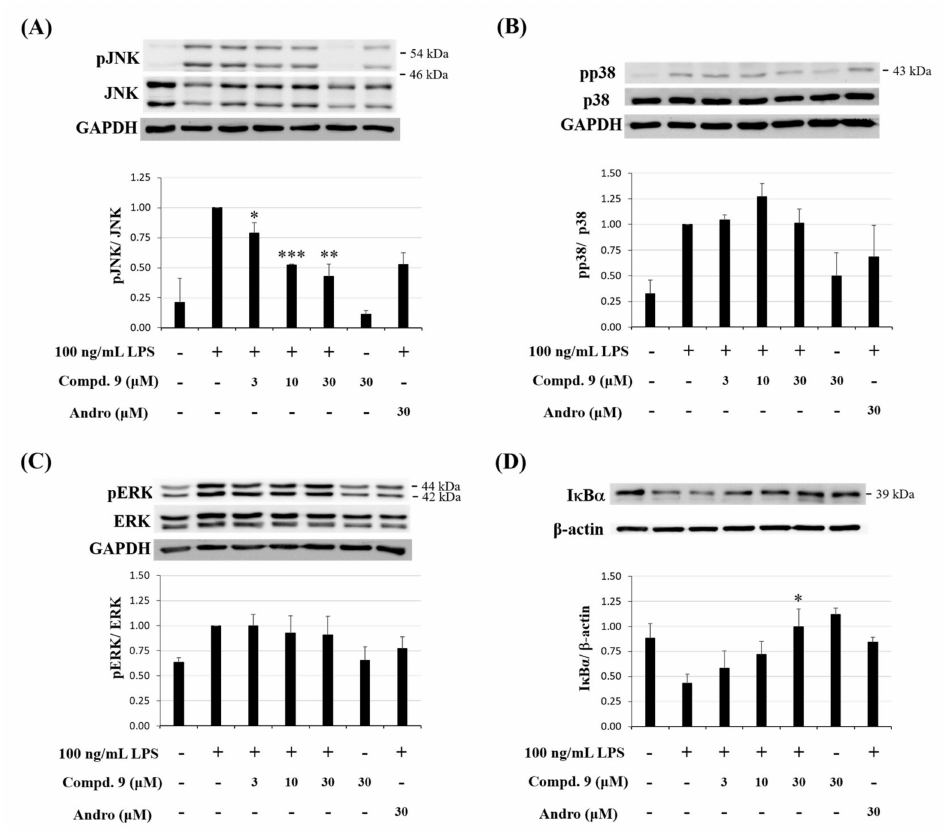
Figure 11. E ff ect of otogirinin A ( 9 ) on the phosphorylation of MAPKs and NF- κ B pathways in LPS-stimulated RAW264.7 macrophages. ( A – C ) Cells pretreated with di ff erent concentration of Compound 9 then stimulated with LPS (100 ng / mL). MAPKs and phosphorylation of MAPKs were detected by Western blot antibodies against p-JNK, JNK, p-p38, p38, p-ERK and ERK; ( D ) Cells were pretreated with di ff erent concentration of Compound 9 then stimulated with LPS (100 ng / mL). The expression of I κ B α was detected by Western blot analysis. Data expressed as means ± SEM (n = 3). Asterisks indicate significant di ff erences (* p < 0.05, ** p < 0.01 and *** p < 0.001) from the (media + LPS) control